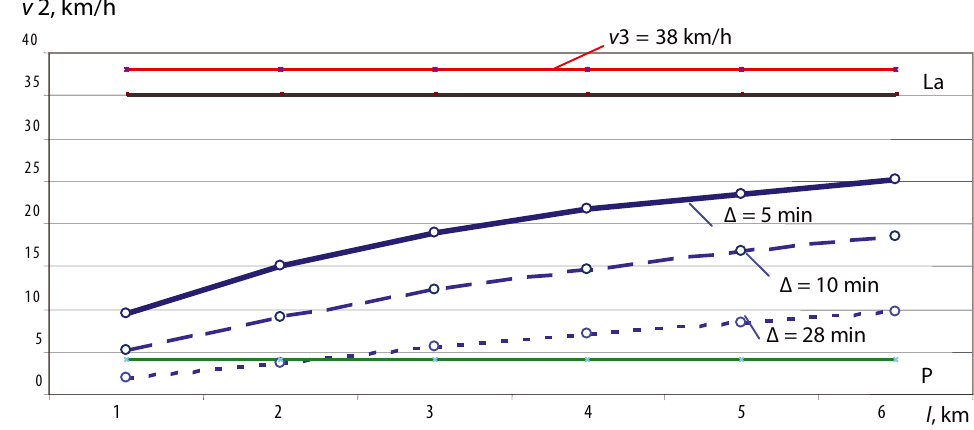
ėjimo pėsčiomis (P) greičiai, km/h Fig. 8. Dependence of passenger communication rate ( v 2) on public transport rate ( v 3), extra time expenses (arriving at stop, waiting, etc.) and length ( 1 ) of passenger travel distance in comparison with average rates of car (La) and walking (P),